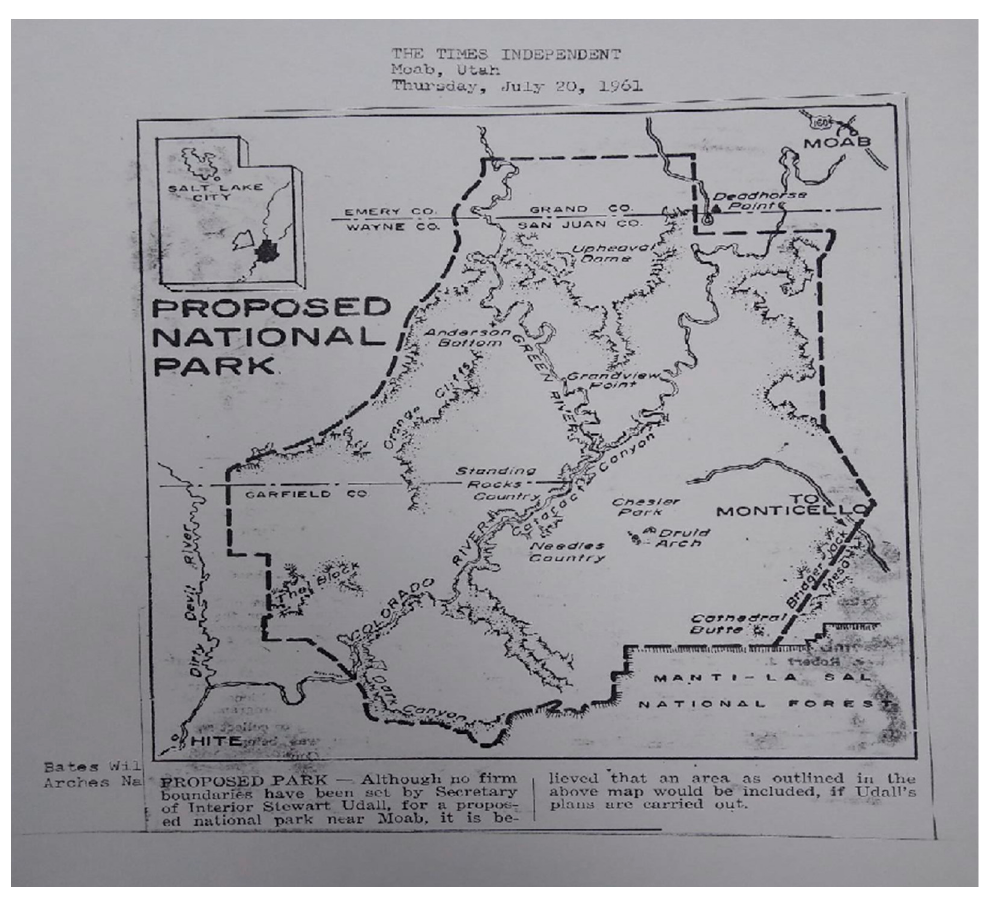
Figure 7. Boundaries for Udall’s original proposed national park. Source: The Times Independent.